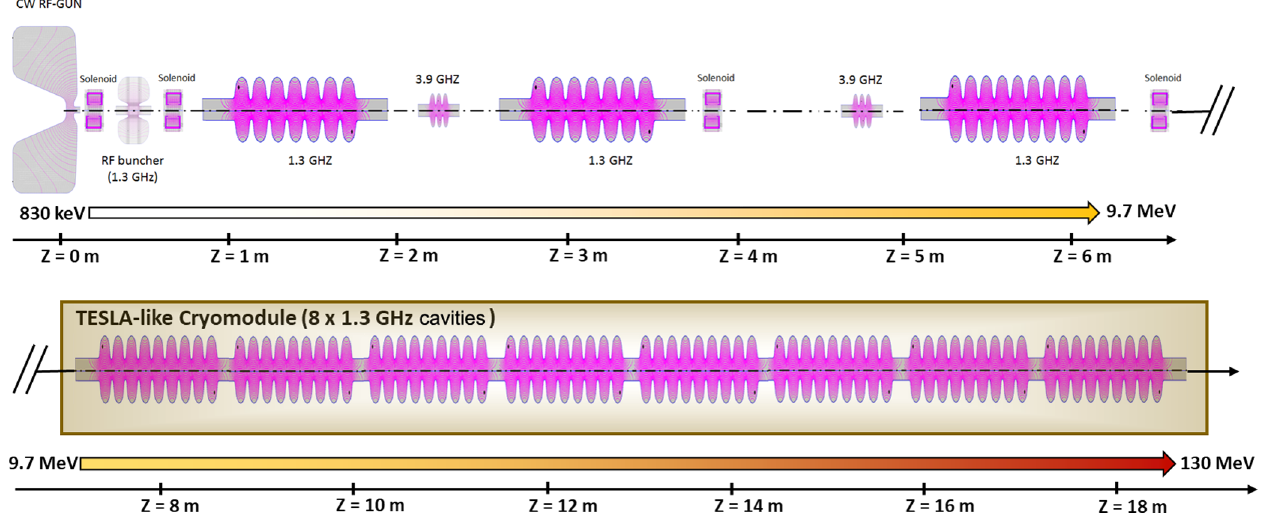
FIG. 3. The injector layout: the beam is extracted in an APEX-like gun; four solenoids are used to control envelopes and emittance oscillations. The LPS shaping and the initial acceleration are performed by a single cell buncher, two 7-cells, one 9-cells SC cavities working at 1.3 GHz and by two short 3.9 GHz high-harmonic cavities. Finally a TESLA cryomodule accelerates the bunch at 130